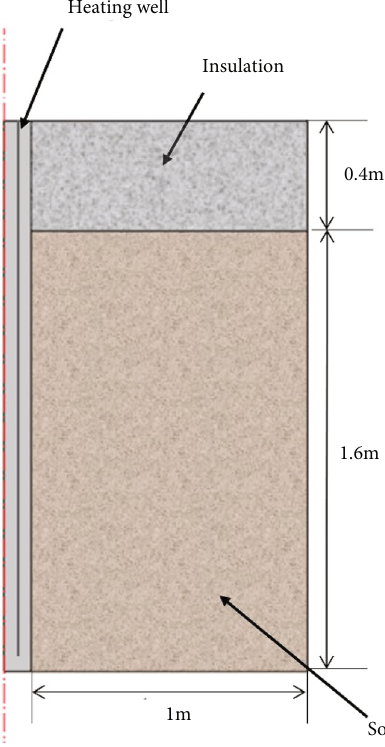
Figure 2: Two-dimensional axisymmetric geometric model of heating unit for